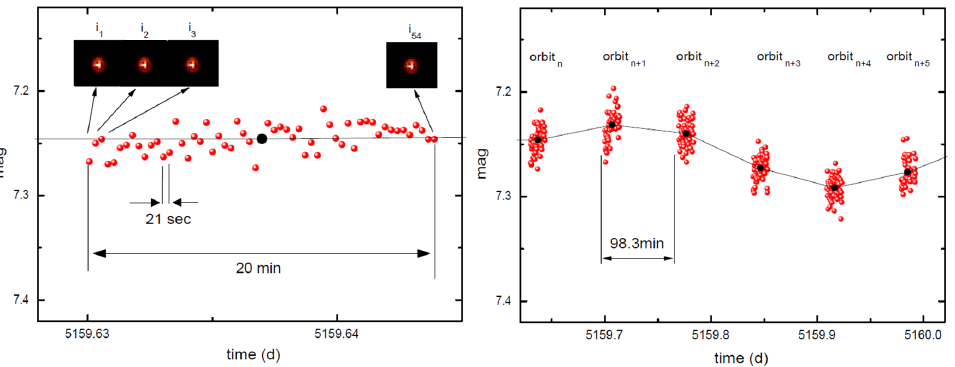
Figure 6. A typical photometric sequence of 44 Cyg (Zwintz [44]), observed by BRITE-Toronto in the field during a single orbit ( left ) and the data sequence during six consecutive orbits ( right ), indicating intrinsic light